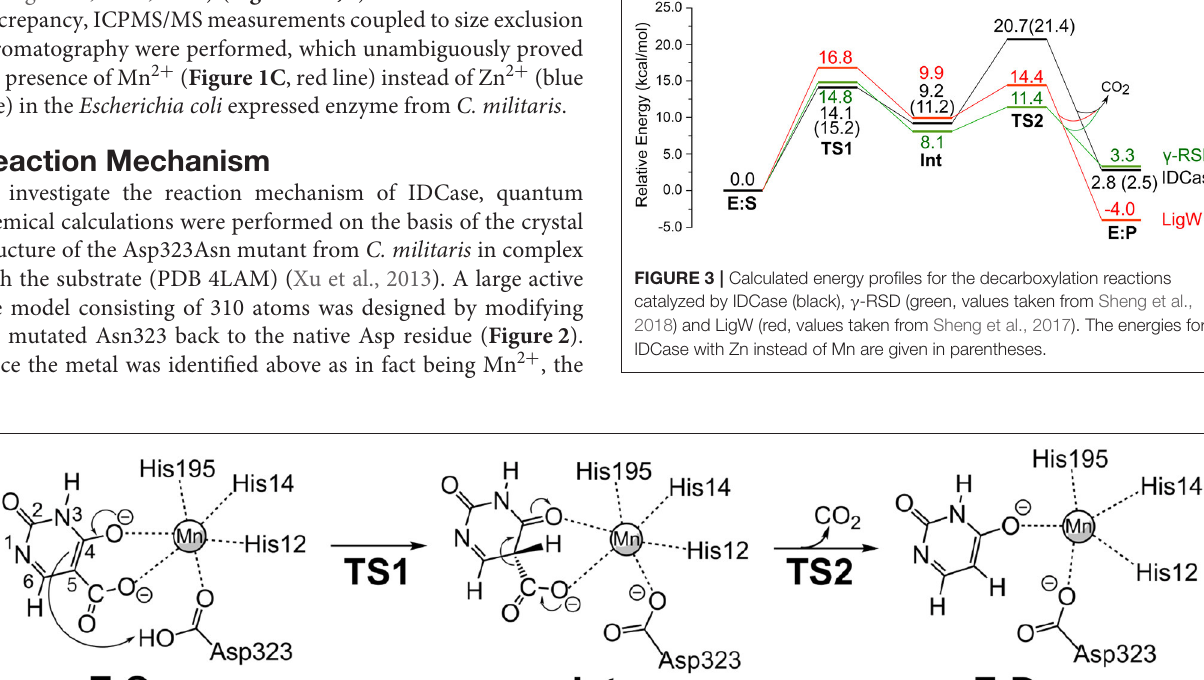
Frontiers in Chemistry |